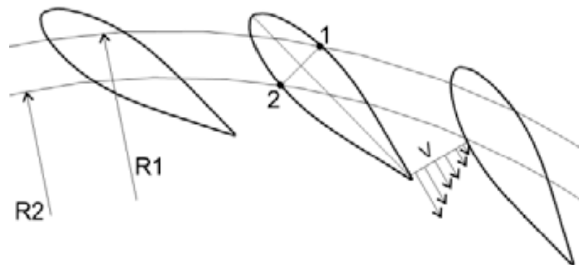
Figure 2. Guide Vane Cascade. 1: Outer Point in guide vane; 2: Inner Point in guide vane; R1: Radius of point 1; R2: Radius of point 2; v: Flow velocity in cascade.